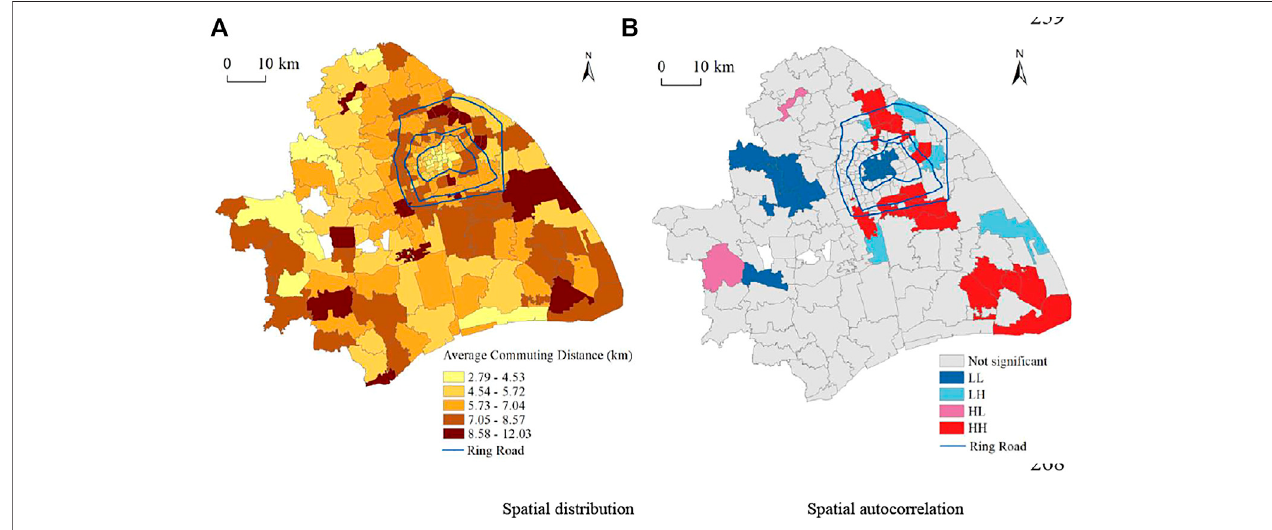
FIGURE 4 | Spatial variations of commuting duration in Shanghai Metropolitan Area. (A) Spatial distribution and (B) spatial autocorrelation.